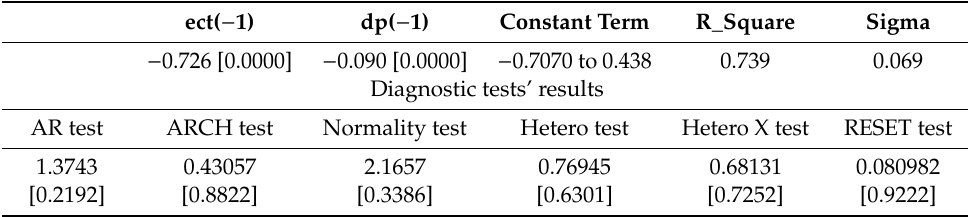
Table 5. TVCC short-run estimation results.